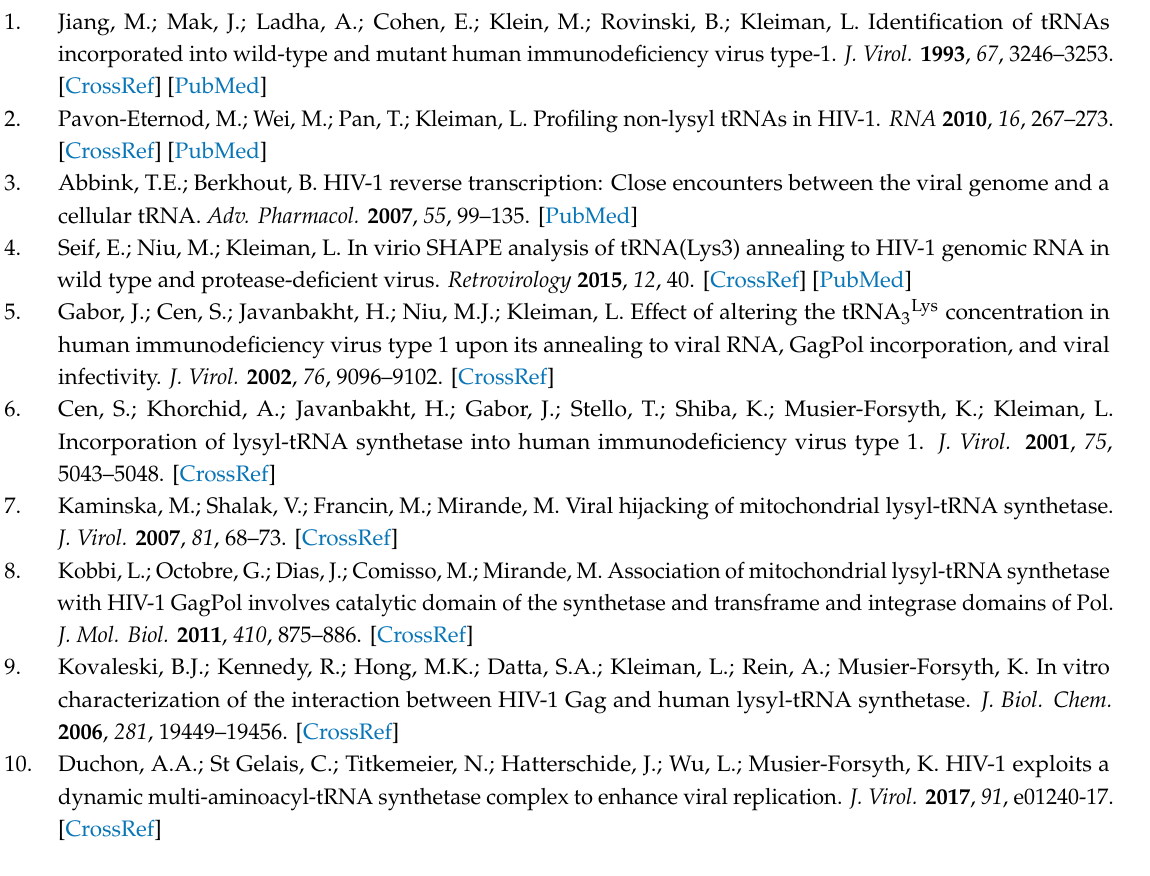
Figure S1: Characterization of polyclonal anti-IN-CTD antibodies, Figure S2: Localization of p Bpa-cross-linked residues on the 3D structure of LysRS, Figure S3: Localization of pBpa-cross-linked residues on the 3D structure of IN-CTD, Figure S4: Pipeline used for the generation of the structural model of mLysRS:IN-CTD complex, Figure S5: Interaction of suggested key residues at the interface of mLysRS with the CTD of HIV-1 integrase, Table S1: Sequence identities between IN species, Table S2: Position of p Bpa insertion into mLysRS, Table S3: Position of p Bpa insertion into IN-CTD222 ∆ C10 from HIV-1, Table S4: Mutations supposed to alter association of mLysRS with